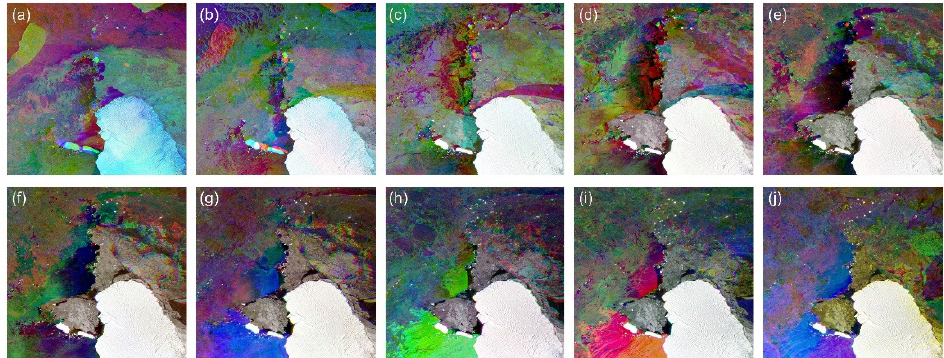
Figure 9. Stacked layer composite images of ASAR WSM images taken from January to December 2010. Each image was synthesised using three WSM images in three consecutive months. For instance, ( a ) January, February and March, ( b ) February, March and April, and ( j ) October, November and December.